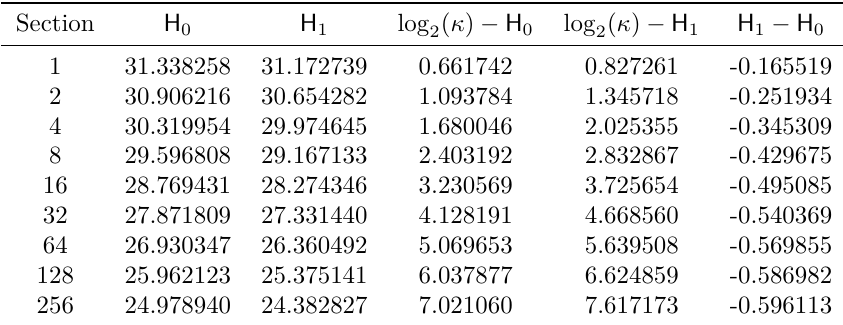
Table 2: H 0 and H 1 -entropy for 16-bit truncated Simon (key size is 32 bits).